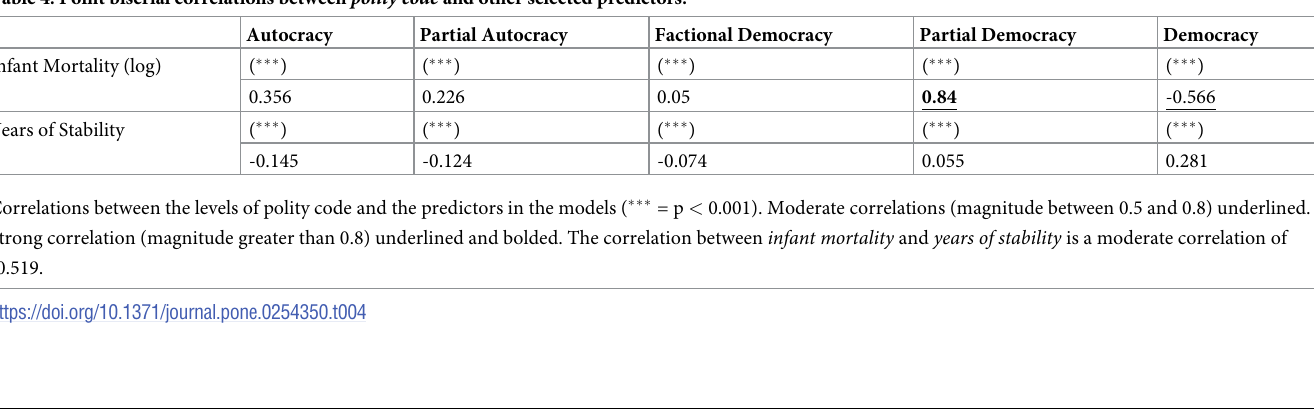
Correlations between the levels of polity code and the predictors in the models ( ��� = p < 0.001). Moderate correlations (magnitude between 0.5 and 0.8) underlined. Strong correlation (magnitude greater than 0.8) underlined and bolded.